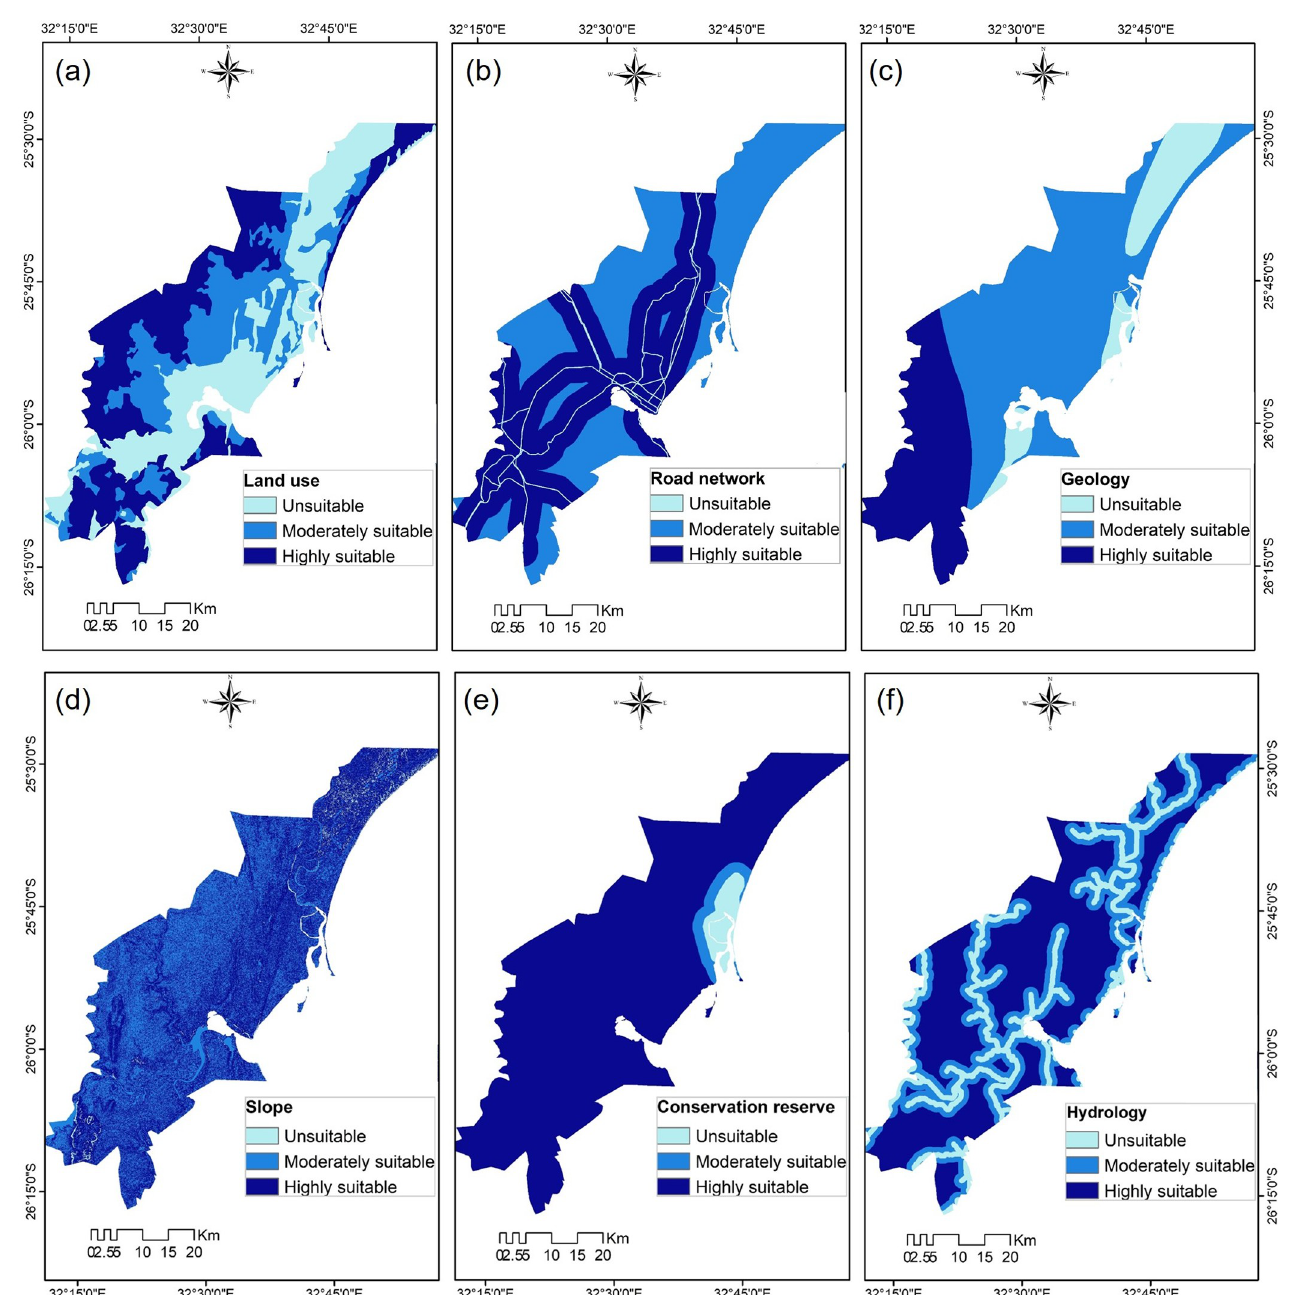
Fig 4. Criteria maps. Classification of unsuitable, moderately suitable and highly suitable areas: (a) land use; (b) transport network; (c) geology; (d) slope; (e) conservation reserve; (f) hydrology. Maps were edited from Landsat [45] and USGS EROS